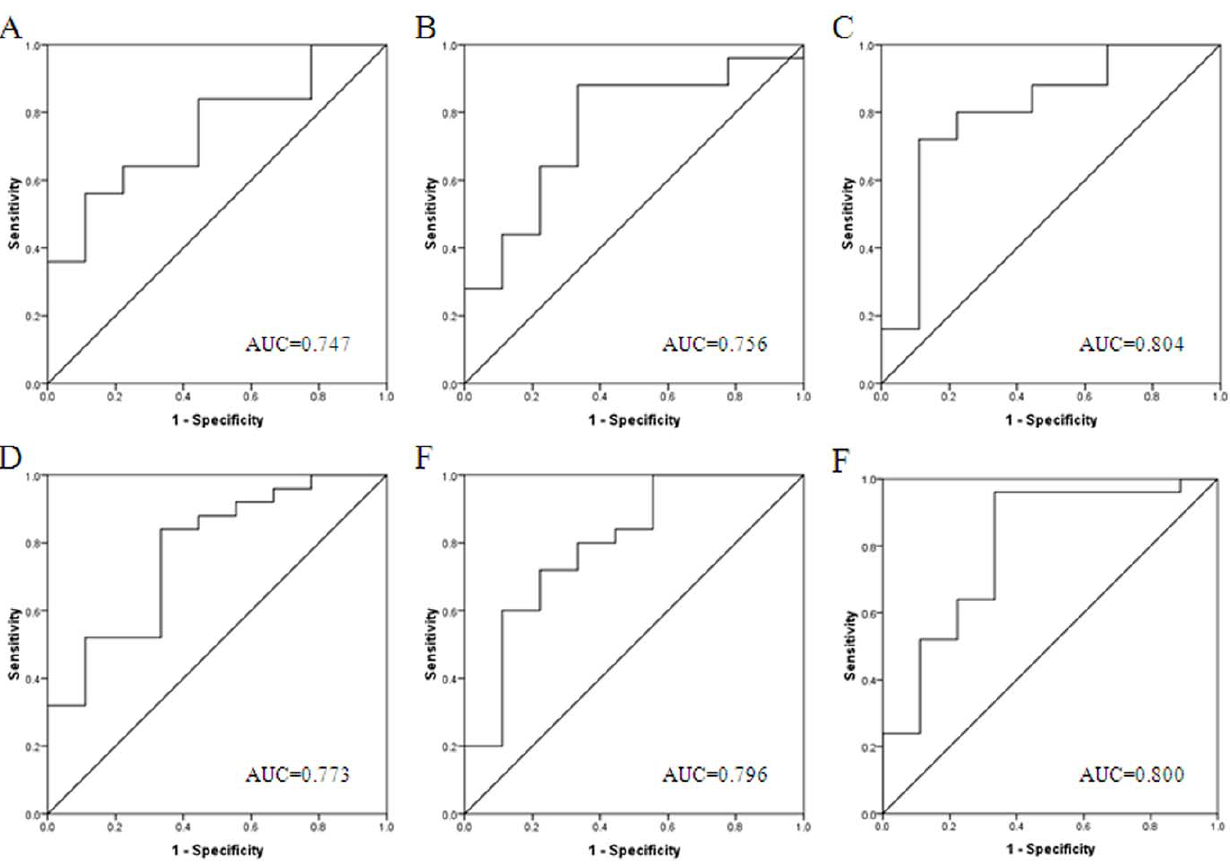
Figure 6. Receiver operating characteristic curve analysis was employed to determine whether the miRNAs found are really good candidates to discriminate the presence or absence of lymph node metastasis. The sensitivity and specificity for each miRNA were plotted: